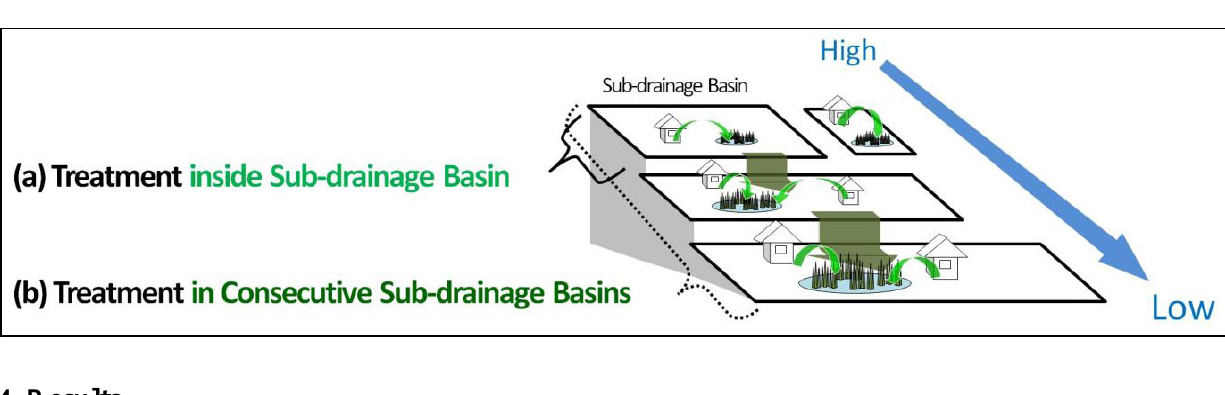
Figure 10. The two scenarios for estimating the potential for abandoned paddy fields to reduce pollution